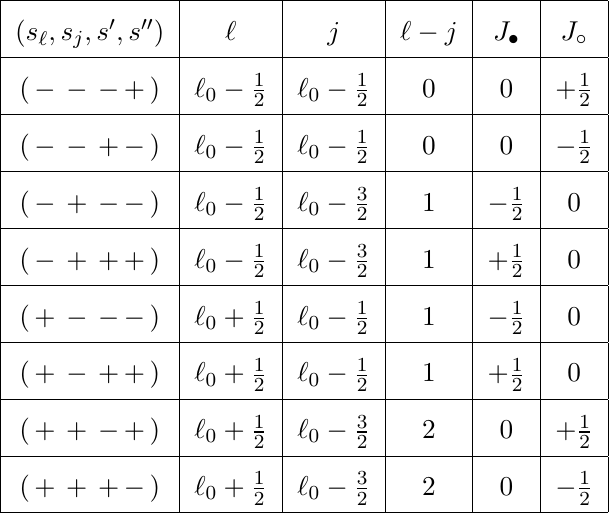
(cid:0) (cid:1) (cid:6) 1 ; (cid:6) 1 ; (cid:6) 1 ; (cid:6) 1 . 2 2 2 2